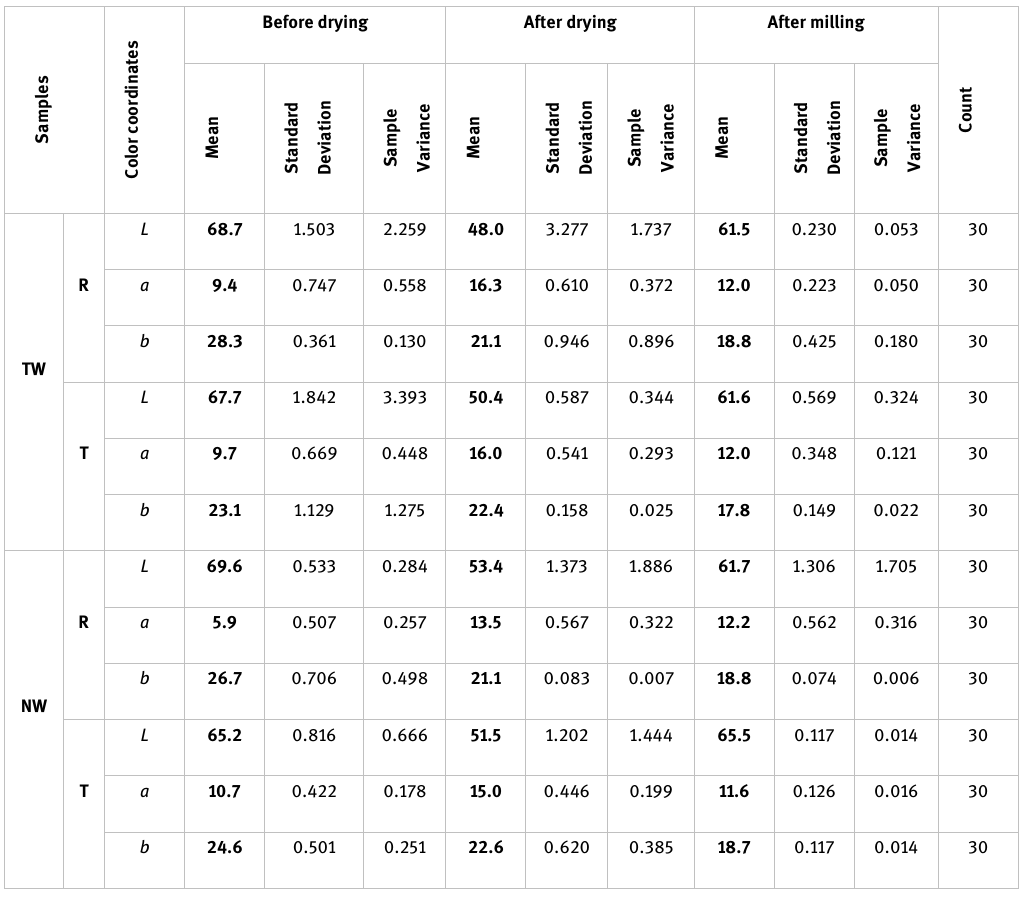
Table 3: Basic statistical characteristic of color coordinates Before drying After drying After milling